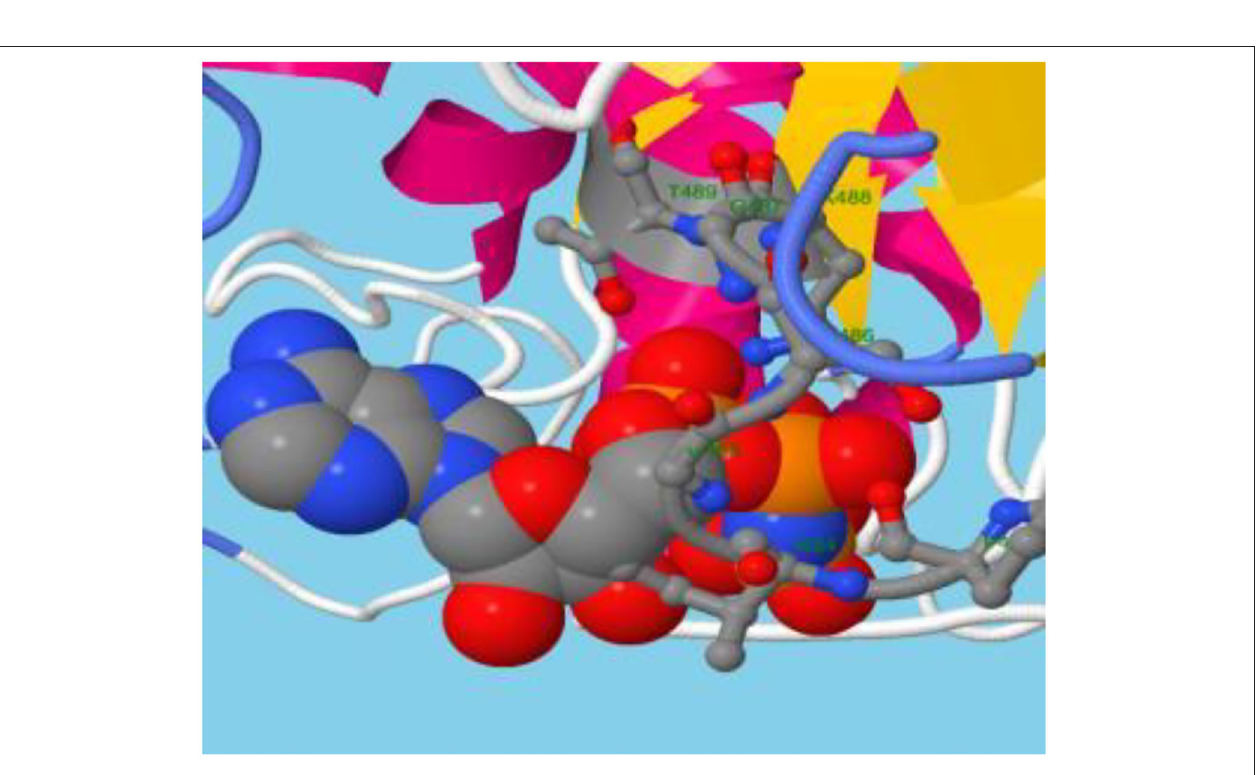
FIGURE 5 | ABC transporter carries the